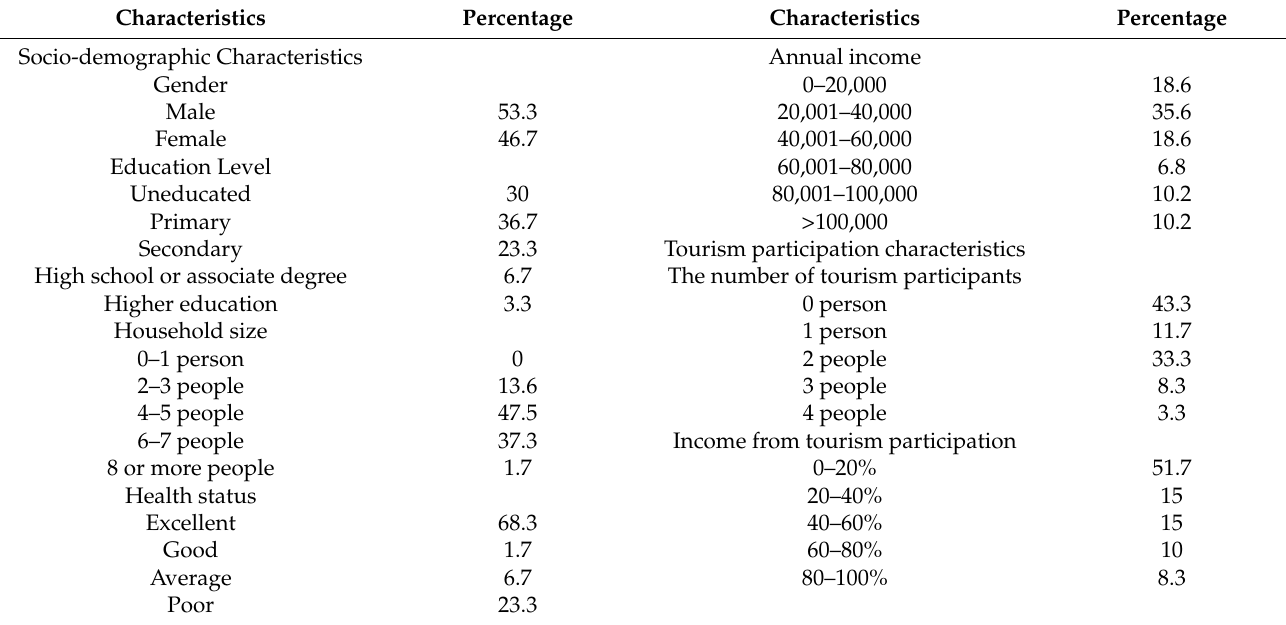
Table 2. Summary of household socio-demographic and tourism participation characteristics.